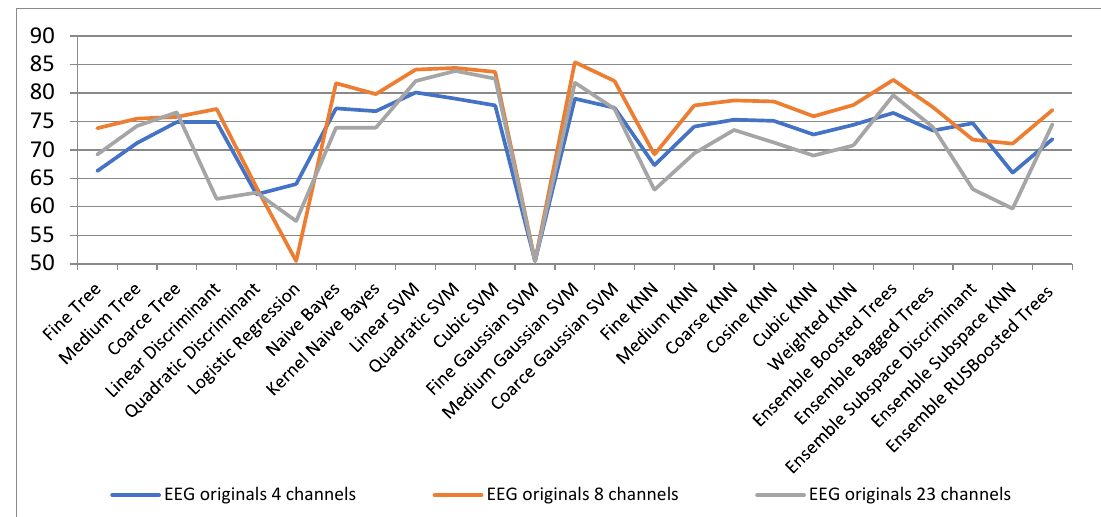
Figure 10. Classification results with original EEG signals for configurations with 4, 8 and 23 channels.